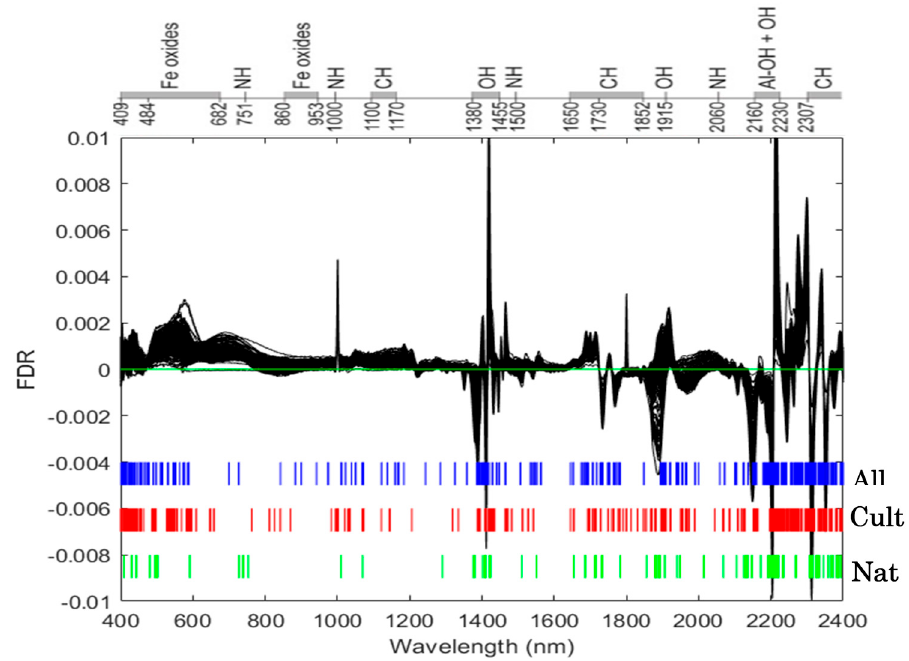
Figure 7. Wavebands used in the ISE–PLS analysis for all combined data (blue bars, All), cultivated systems (red bars, Cult), and natural systems (green bars, Nat) using the first derivative reflectance (FDR) dataset to estimate oxalate-extractable phosphorus. Specific absorption wavebands for the different bonds present in soil are specified on the top x-axis (modified from Kawamura et al. [25]).